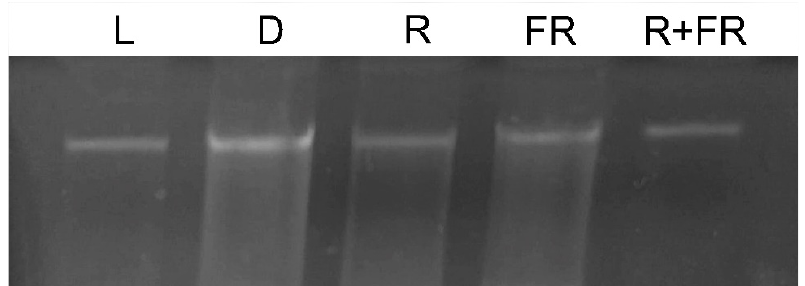
Figure 1. Genomic DNA from maize leaves under different light conditions. L, plants illuminated with white light; D, plants kept in darkness; R, plants illuminated with red (660 nm) light; FR, plants illuminated with far-red (730 nm) light; R+FR, plants illuminated with red (660 nm) followed by far-red (730 nm) light.